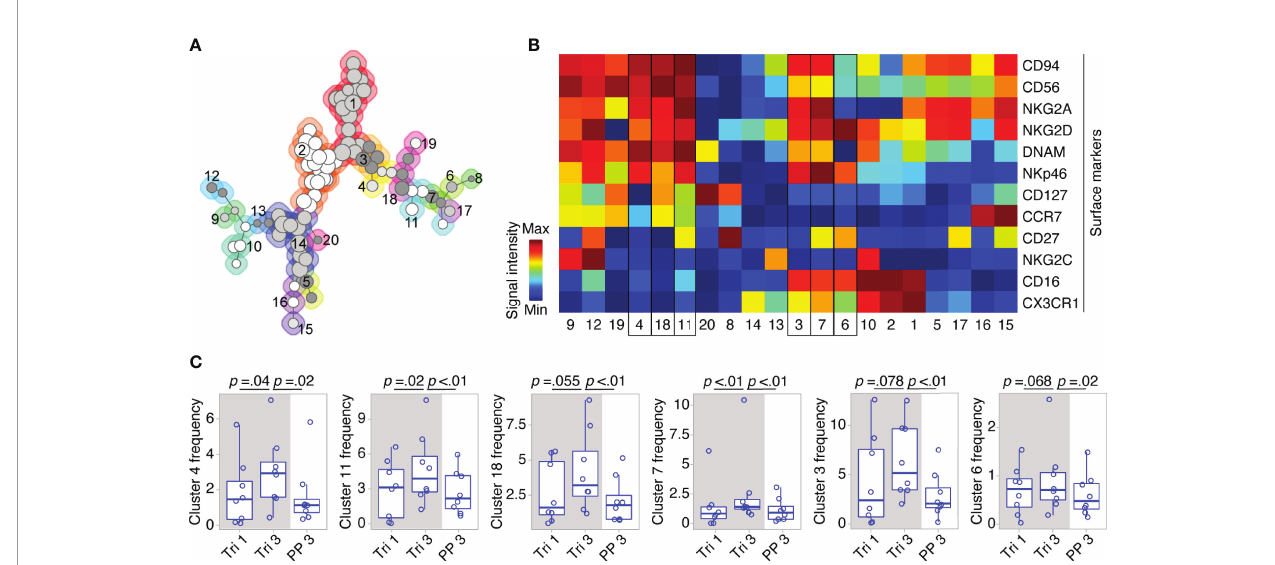
FIGURE 3 | Clusters within CD56 bright and CD56 dim NK cell populations display dynamic shifts in MS pregnancy. In a detailed phenotypic analysis during and after pregnancy in MS patients (Berlin cohort), FlowSOM identi fi ed 20 distinct clusters among pre-gated Lin - CD56 + NK cells. Clusters are numbered and indicated by shades of grey and differently coloured backgrounds (for details of FlowSOM see Supplementary Figure 2 and Methods) (A) . Surface marker expression of each cluster is shown in the heatmap. For all markers except CD56, dark blue indicates negative expression and dark red indicates highly positive expression. For CD56, dark blue to green indicates dim expression (as all analyzed cells are CD56 + ) and dark red indicates bright expression (B) . Clusters with frequency changes throughout pregnancy and the postpartum period (six clusters with smallest p-values shown). Cluster frequency referred to as percentage of Lin - CD56 + NK cells (C) . Cluster 3 and 7 contain CD56 bright and CD56 dim NK cells as indicated by a medium CD56 expression in the heatmap (yellow to orange). Mixed composition of cluster 3 and 7 has been additionally con fi rmed by manual gating. Boxplots depict median and inter-quartile range, overlaid with datapoints of individuals. The gray box represents pregnancy. Statistical analysis performed by Wilcoxon paired test between trimesters 1 and 3, as well as trimester 3 and 3 months